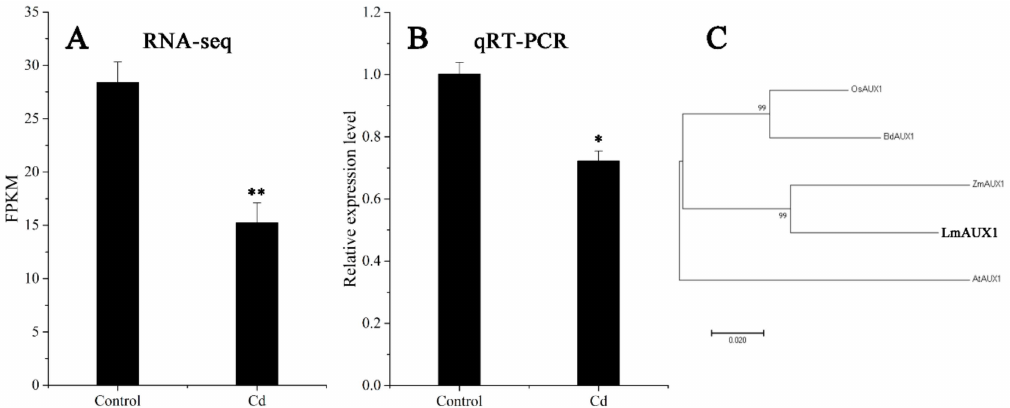
Figure 5. Expression level and phylogenetic tree analysis of AUX1 . ( A ) Expression level of LmAUX1 calculated by RNA-seq. Data are means ± SE (n = 3). Asterisks indicate significant di ff erences (** p < 0.01 by Duncan’s test). ( B ) Relative expression level of LmAUX1 verified by qRT-PCR. Data are means ±